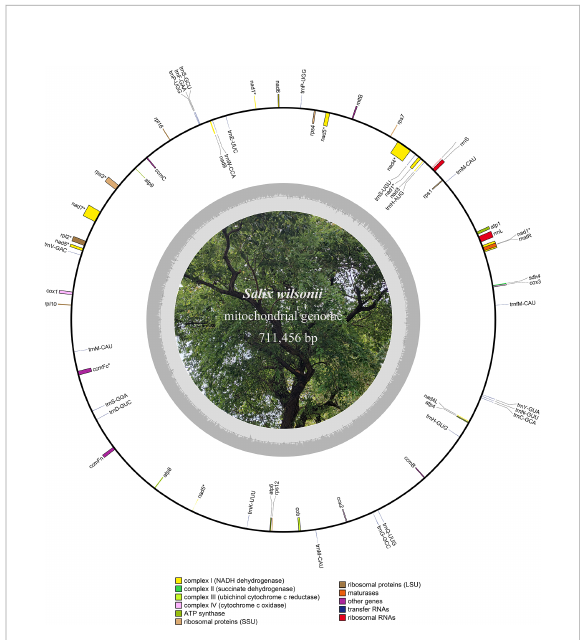
FIGURE 1 Circular map of the S. wilsonii mitogenome. The inner circle in gray represents the GC content of the